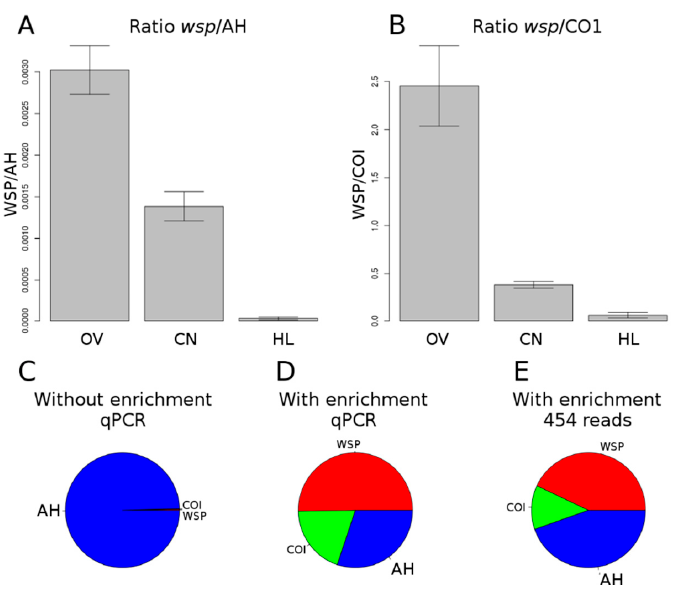
Figure 1. Ratios of wsp gene copy number relative to androgenic hormone (AH) copy number ( A ) and cytochrome oxidase I (COI) copy number ( B ), in ovaries (OV), nervous cord (CN) and hemolymph (HL). Proportions of base pairs based of w Con (red), mitochondrial (green) and nuclear genomes (blue) estimated by quantitative PCR (qPCR) without ( C ) and with ( D ) enrichment, and by mapping of pyrosequencing reads on assembled genomes ( E ). WSP: please define.